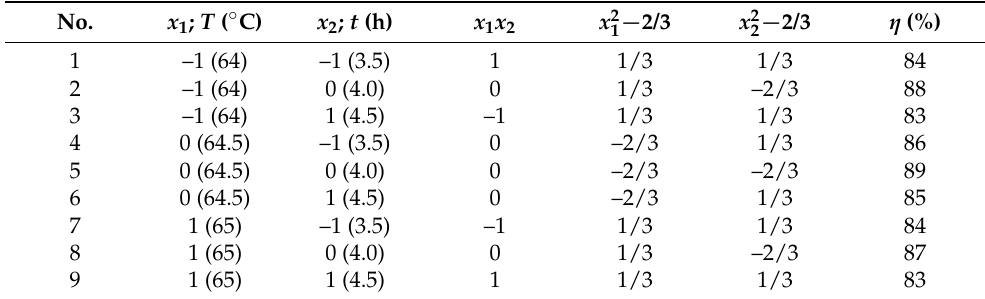
Table 3. Dimensionless variables and the measured reaction’s yield for obtaining the compound VII